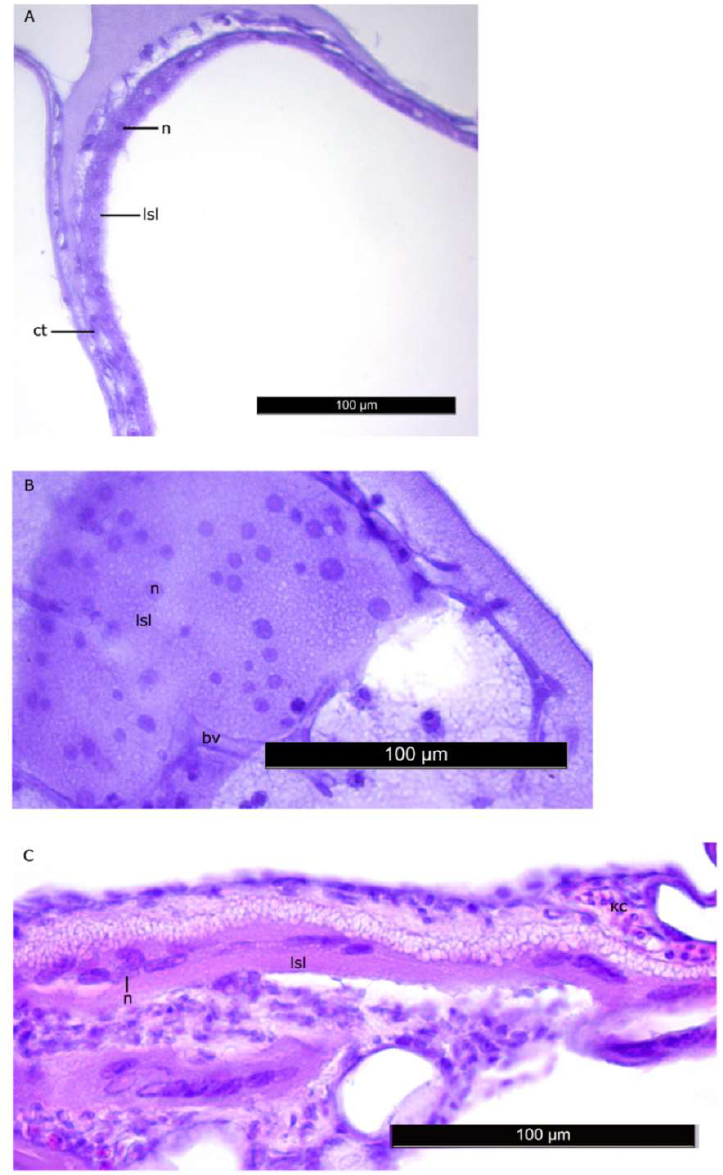
Figure 5. Nuclei of the LSL of LS at the L2 stage ( A , B ) and L5 stage ( C ). Nuclei generally have regular shapes, their linear sizes increase by the stage L5. Figure legend: bv—blood vessel, lsl– lipid syncytial layer, ct—connective tissue, n—nucleus of LSL. The homogenous matrix between the compartments of LS. Staining: Carazzi’s hematoxylin and eosin. Bar: 100 µm.